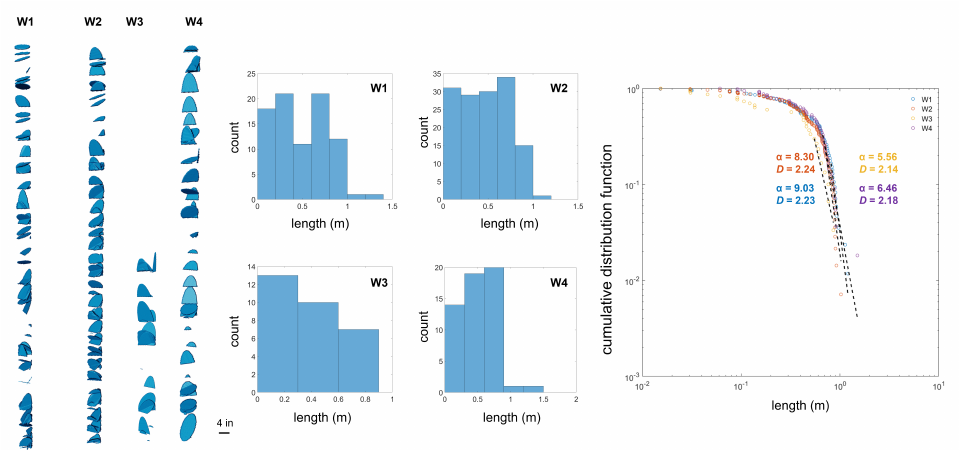
Figure 5. Segmented fracture networks and cumulative distribution function for 3D shale rock images corresponding to samples W1, W2, W3, and